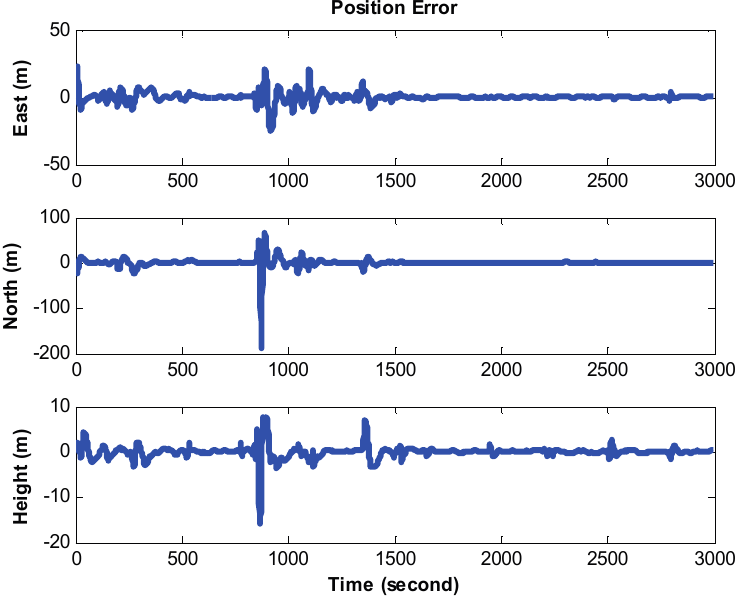
Figure 12. The error comparison for position in airborneland test.